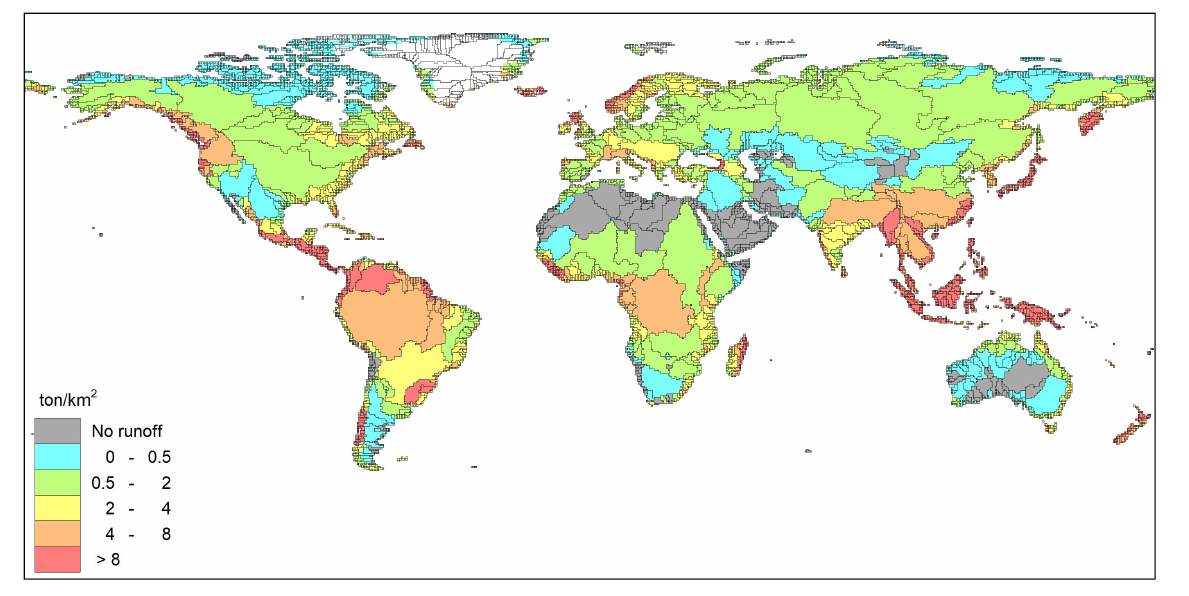
FIGURE6 SiO 2 yield in ton per km 2 for the year 2000. Modified from Beusen et al. (2009).